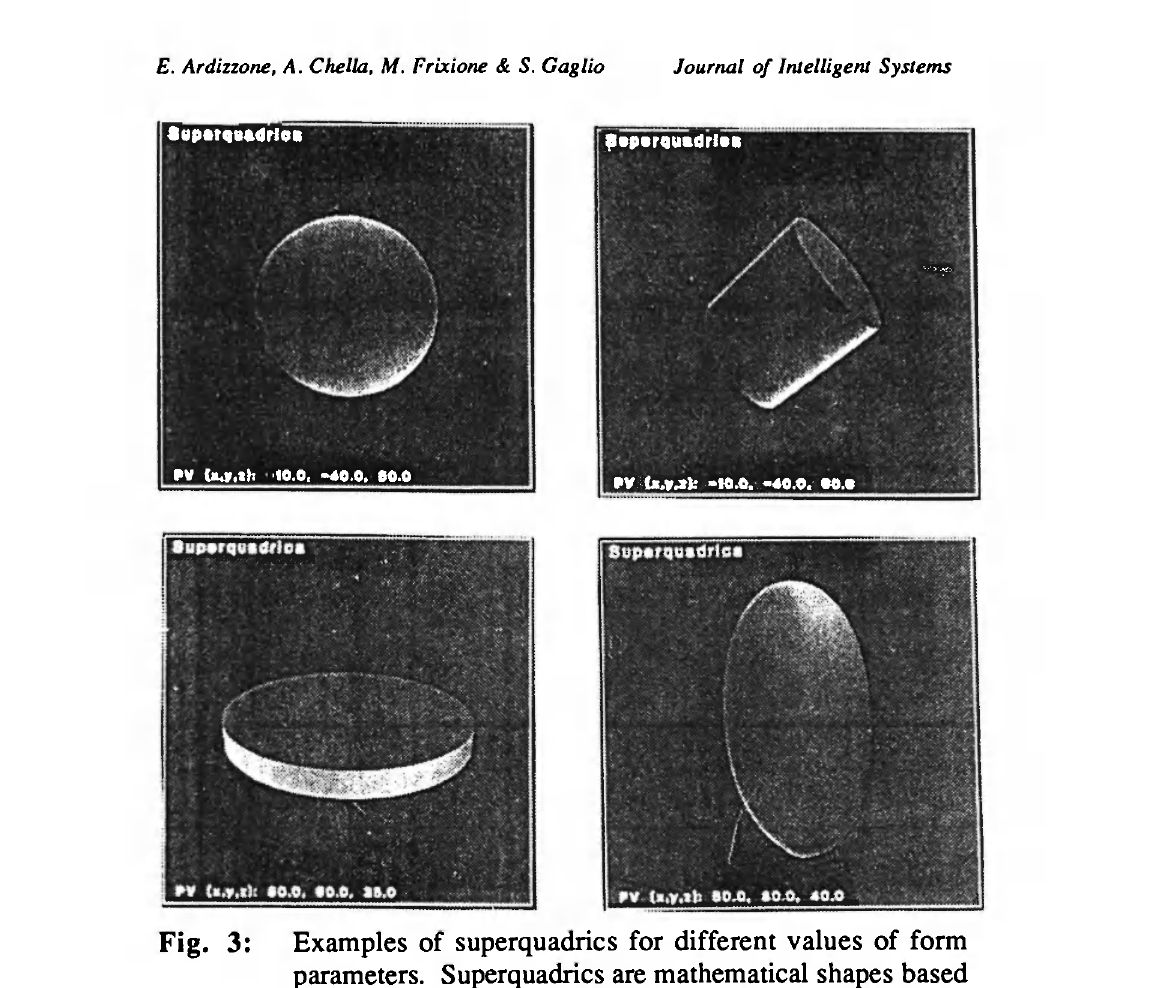
Fig. 3: Examples of superquadrics for different values of form parameters. Superquadrics are mathematical shapes based on the parametric form of quadric surfaces, in which each trigonometric function is raised to one of two real expo- nents ει and £2, called form parameters since a change in these exponents affects the superquadric's surface